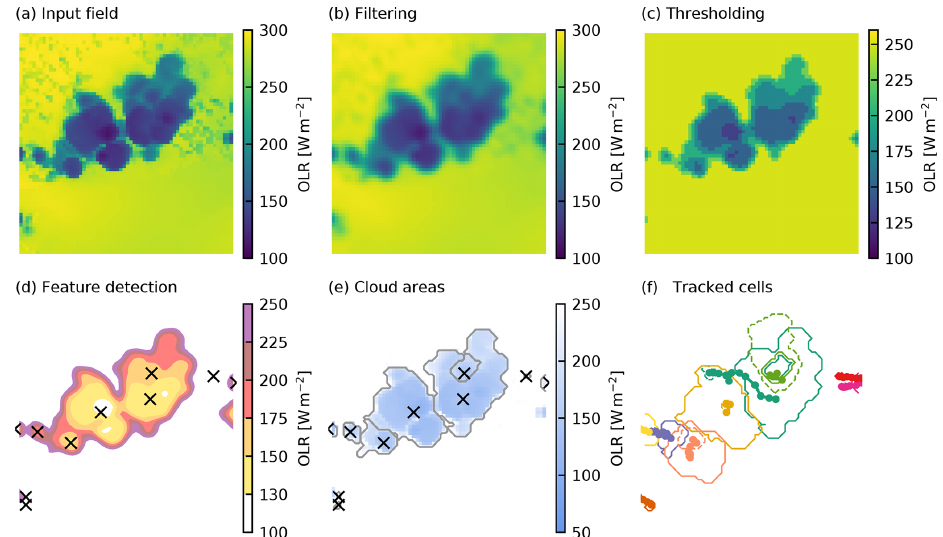
Figure 8. Schematic overview of the individual steps of the tracking algorithm for an example subset of the domain used in example B based on outgoing longwave radiation. The input data (a) are smoothed with a filter (b) before regions above or below a set of thresholds are determined (c) to identify the individual features (d) . (e) The associated cloud areas determined in the segmentation step and (f) all individual clouds present at the time step over their entire life cycle, including an outline of the cloud area at the start (dashed) and at the end (solid) of the